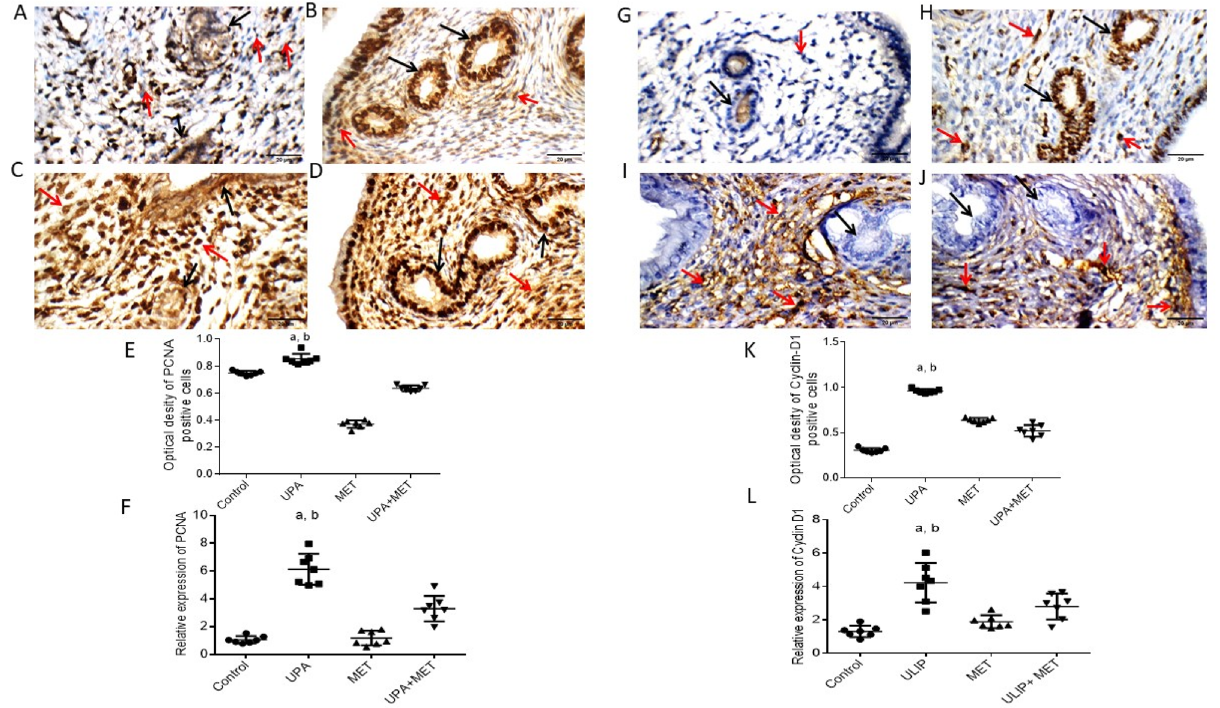
Figure 4. Effect of metformin or/and ulipristal on the expression of the proliferation markers of rats’ uteri. ( A – D ) photomicrographs of uteri shows expression of PCNA ( A ) Uterine wall in the control group. ( B ) Uterine wall in ulipristal treated group. ( C ) Uterine wall in metformin treated group. ( D ) Uterine wall in the ulipristal and metformin treated group. × 400 magnification (scale bar = 20 μm). ( E ) Expression quantification of the optical density reactivity of positive cells of PCNA by the ImageJ analysis system. ( F ) Quantitative RT-PCR analysis of PCNA mRNA expression. ( G – J ) Photomicrographs of uteri shows expression of Cyclin-D. ( G ) Uterine wall in the control group. ( H ) Uterine wall in ulipristal treated group. (I) Uterine wall in metformin treated group. ( J ) Uterine wall in the ulipristal and metformin treated group. × 400 magnification (scale bar = 20 μm). ( K ) Expression quantification of the optical density reactivity of positive cells by the ImageJ analysis system. ( L ) Quantitative RT-PCR analysis of Cyclin D1 mRNA expression, Black arrow refers to reactivity in endometrial glands, red arrows refers to reactivity in stromal cells. Data in figures ( E ) and ( K ) is represented by mean ± SD (n = 7). All value of RT-PCR is expressed as the change in cycle threshold (ΔCt). Each dot represents mean of each group (n = 7, triplicate for each rat). Negative control (DEPC-treated water) showed no detectable fluorescent signals. a or b, Statistically significant from the control or ulipristal and metformin treated group respectively at P < 0.05 using one-way ANOVA followed by Tukey as a post hoc test. UPA ulipristal, MET metformin, UPA + MET co-treatment with ulipristal and